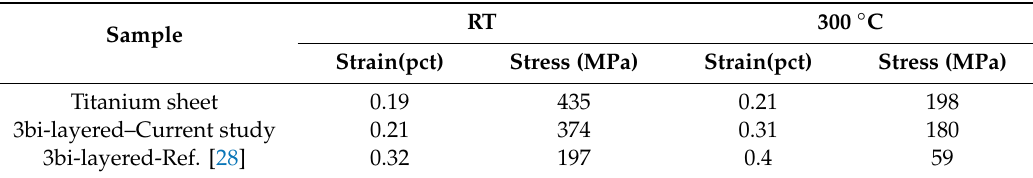
Table 1. Stress and Strain Values Obtained from Tensile Tests at 0.013/s of three bi-layered Type A and titanium Type A sample (at RT).